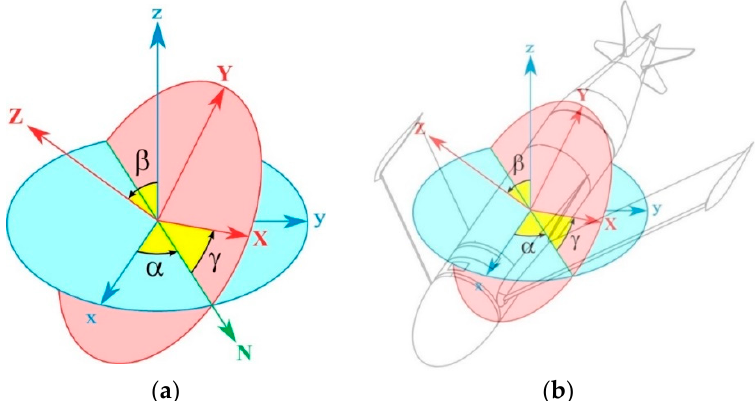
Figure 3. The Euler angles. ( a ) Body frame (blue) and reference frame (red); ( b ) The body frame referred to the drone.